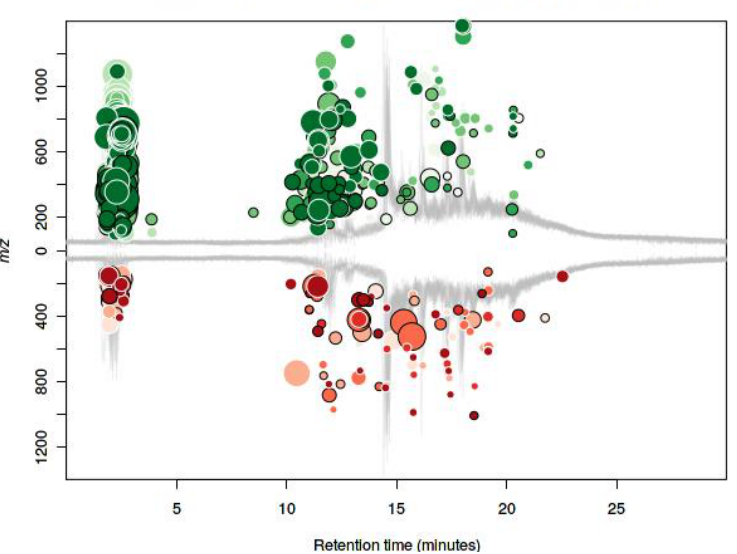
Figure 2. Cloud plot of the metabolomics modulated features (fold change ≥ 1.5, p -value ≤ 0.05). Feature signals belonging to molecules defined by m/z and retention time. Differential analysis based on the intensity of the signals in PRE versus POST run sera. Green and red circles represent the upregulated and downregulated features, respectively. The size value of each circle corresponds to (log) fold change. Color shades are used to represent the p -value, with brighter circles indicating lower p -values. The retention time corrected (TIC) total ion chromatograms are overlaid in gray in the figure background.